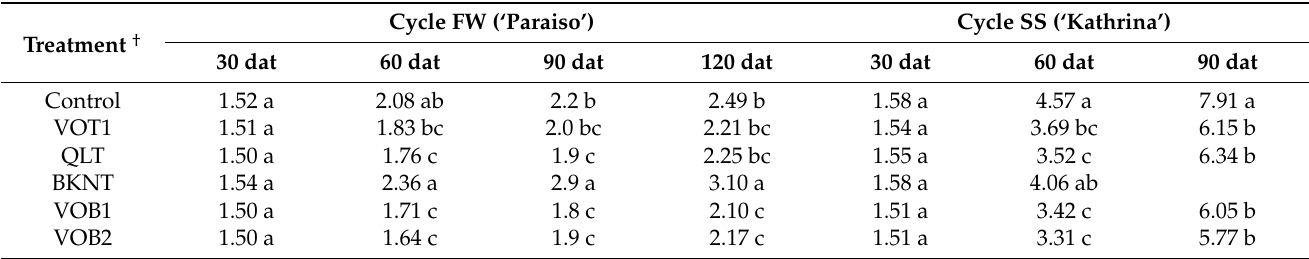
Table 4. Effect of treatments on the degree of severity of downy mildew on cucumber crops during the FW and SS